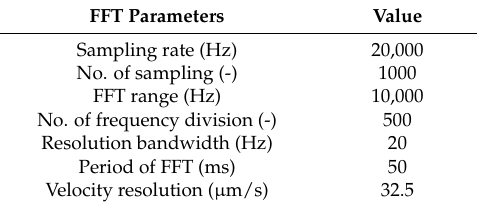
Table 2. Condition of FFT.